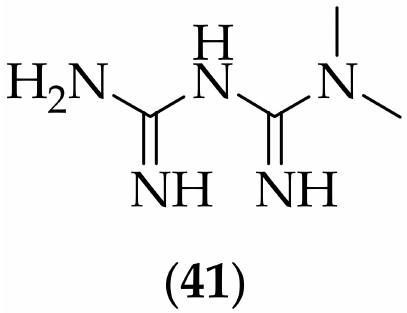
Figure 26. Structure of metformin ( 41 ).